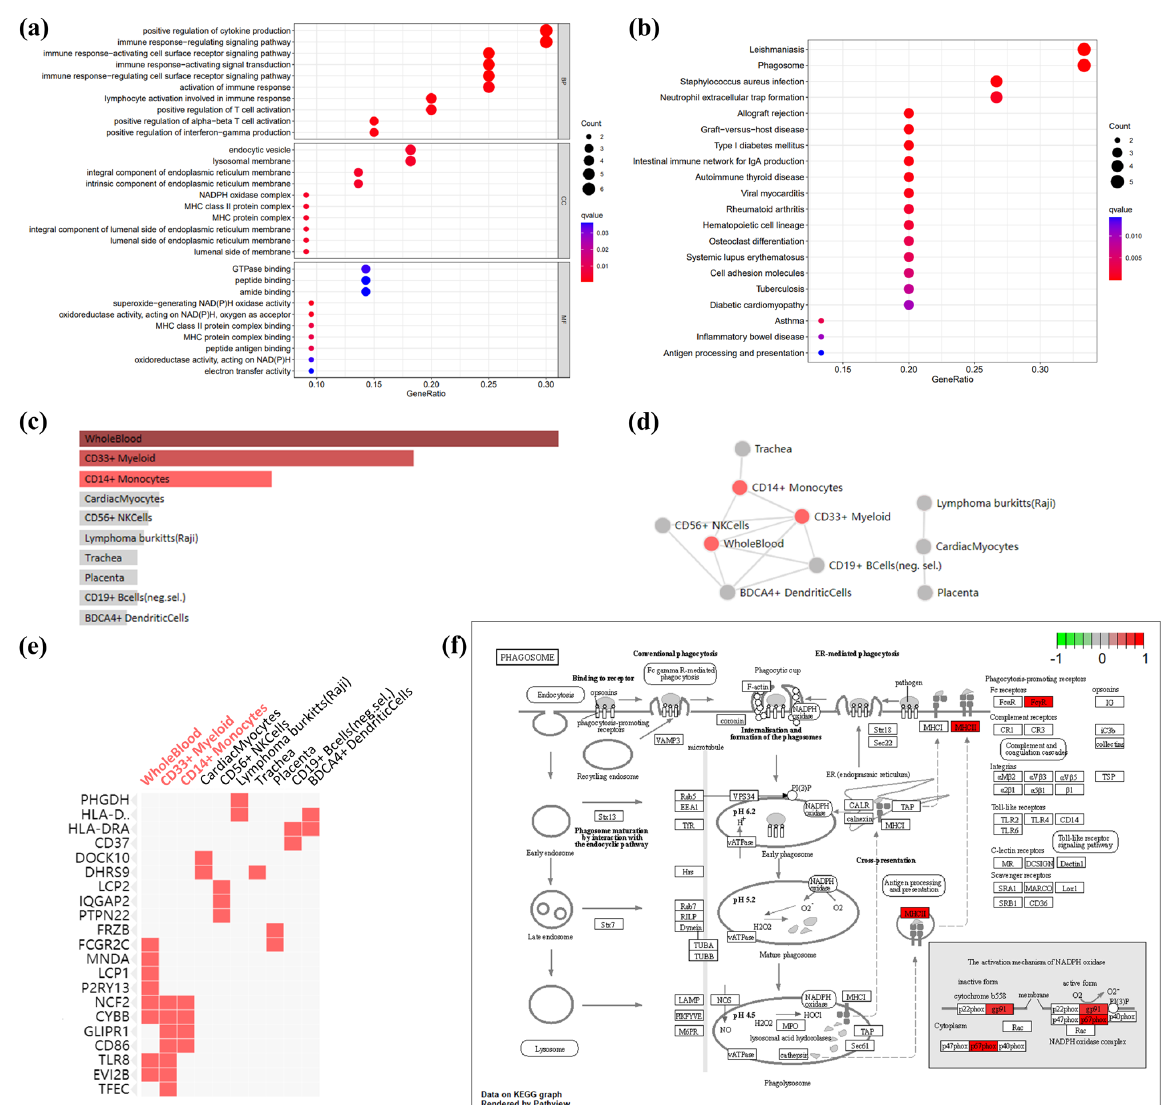
Figure 3. GO terms, KEGG pathway, and cell-type enrichment. ( a ) GO term enrichment for AF- and obese-related co-DEGs. Dot sizes, counts of enriched DEGs; dot colors, q value. ( b ) KEGG pathway of AF- and obese-related co DEGs. Dot sizes, counts of enriched DEGs; dot colors, q value. ( c ) Bar graph showing p -value for Enrichr cell-type enrichment, sorted by p -value ranking. Red nodes, adjust p -value < 0.05; gray nodes, adjust p -value > 0.05. ( d ) Network showing the interaction of enriched cell types. Red nodes, adjust p -value < 0.05; gray nodes, adjust p -value > 0.05. ( e ) Clustergram shows the relationship between cell-type enrichment and genes, sorted by p value ranking. Enriched terms are the columns, input genes are the rows, and cells in the matrix indicate if a gene is associated with a term. ( f ) KEGG pathway map of the phagosome, which is enrichment in co DEGs: CYBB (gp91), NCF2 (p67phox), HLA-DRA (MHCII), and FCGR2C (Fc γ R). Red, up-regulated genes; green, down-regulated